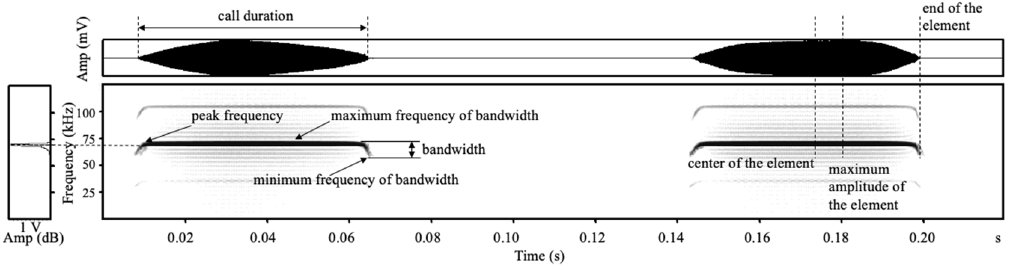
Figure 3. Acoustic parameters and locations of echolocation call measurements for Rhinolophus ferrumequinum .